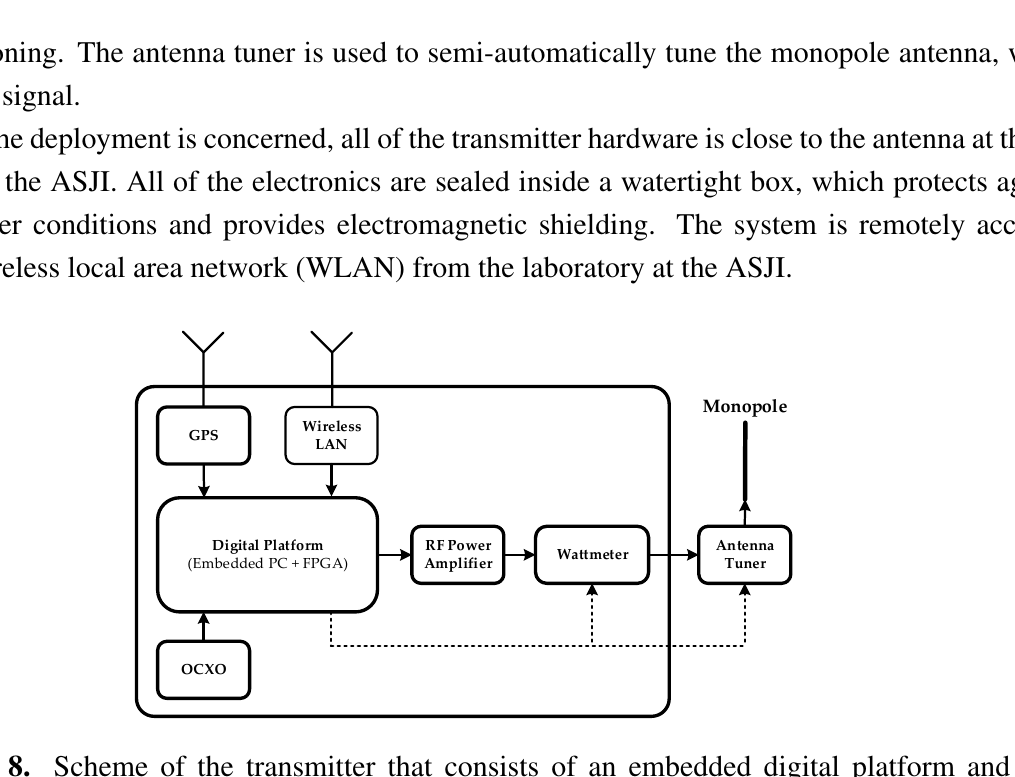
Figure 8. Scheme of the transmitter that consists of an embedded digital platform and different peripherals used to control the system and to improve the synchronization.